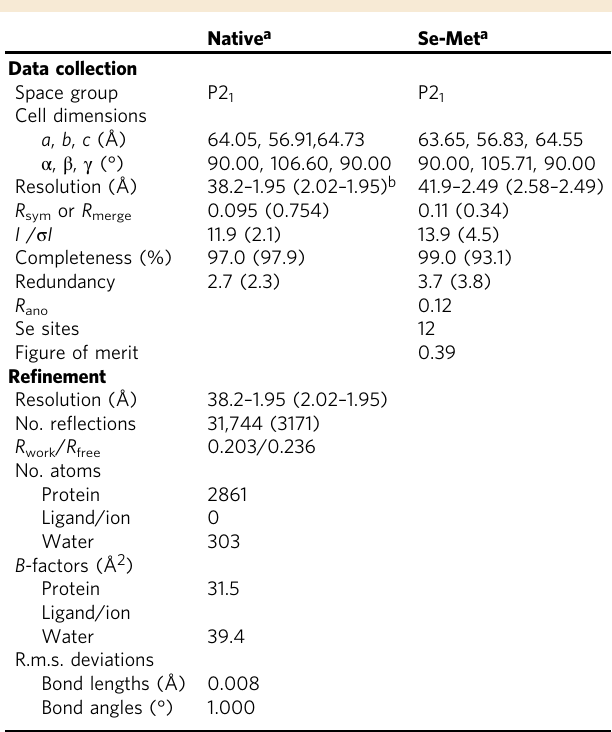
Table 1 Data collection and re fi nement